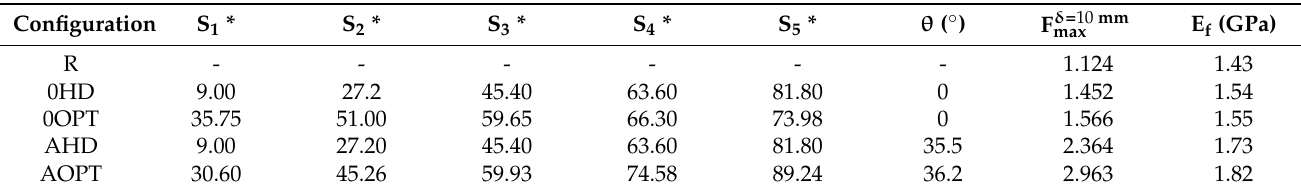
Table 3. Optimal designs found for each panel